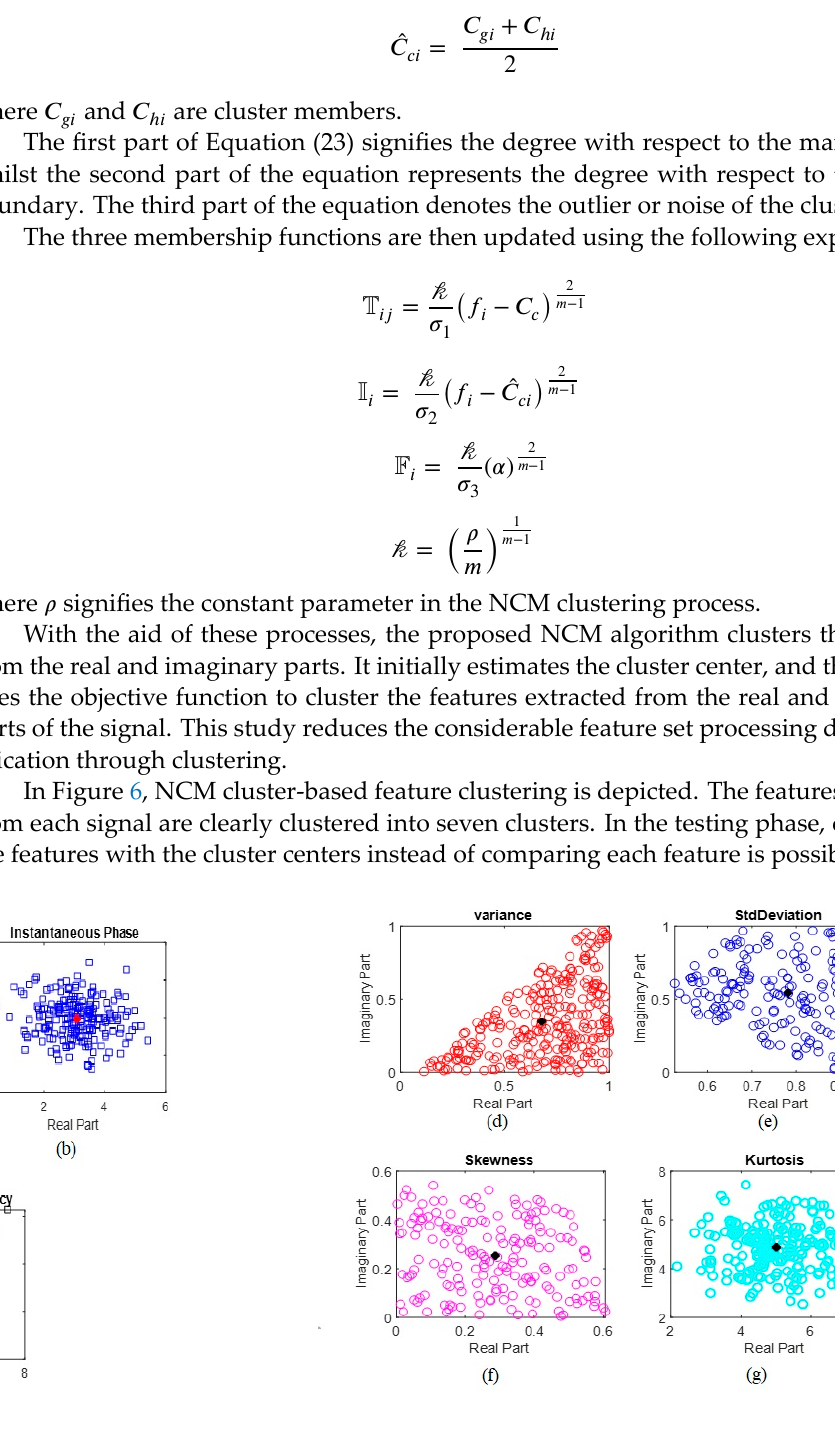
Figure 6. Feature clustering in TL‑CapsNet. ( a ) Cluster of instantaneous amplitude; ( b ) Cluster of instantaneous phase; ( c ) Cluster of instantaneous frequency; ( d ) Cluster of variance; ( e ) Cluster of standard deviation; ( f ) Cluster of skewness; ( g ) Cluster of kurtosis.